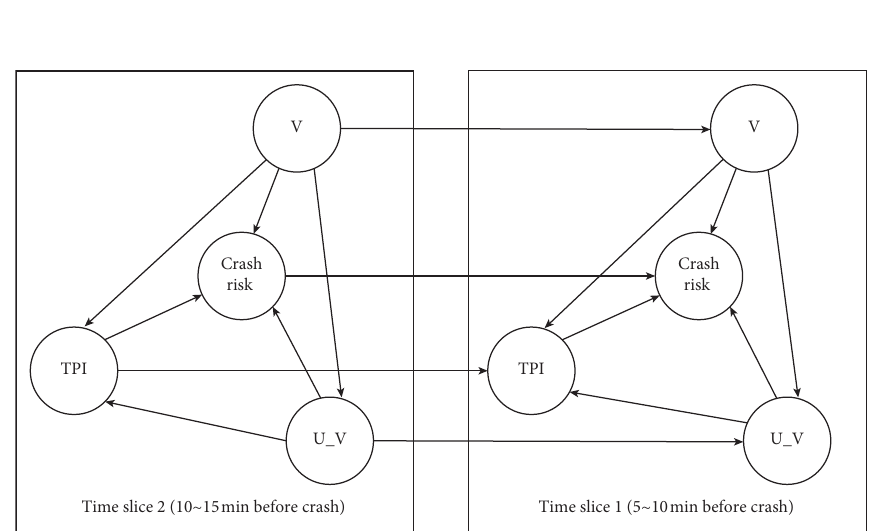
Figure 6: Graphical structural of the improved DBN-based RTCPM.